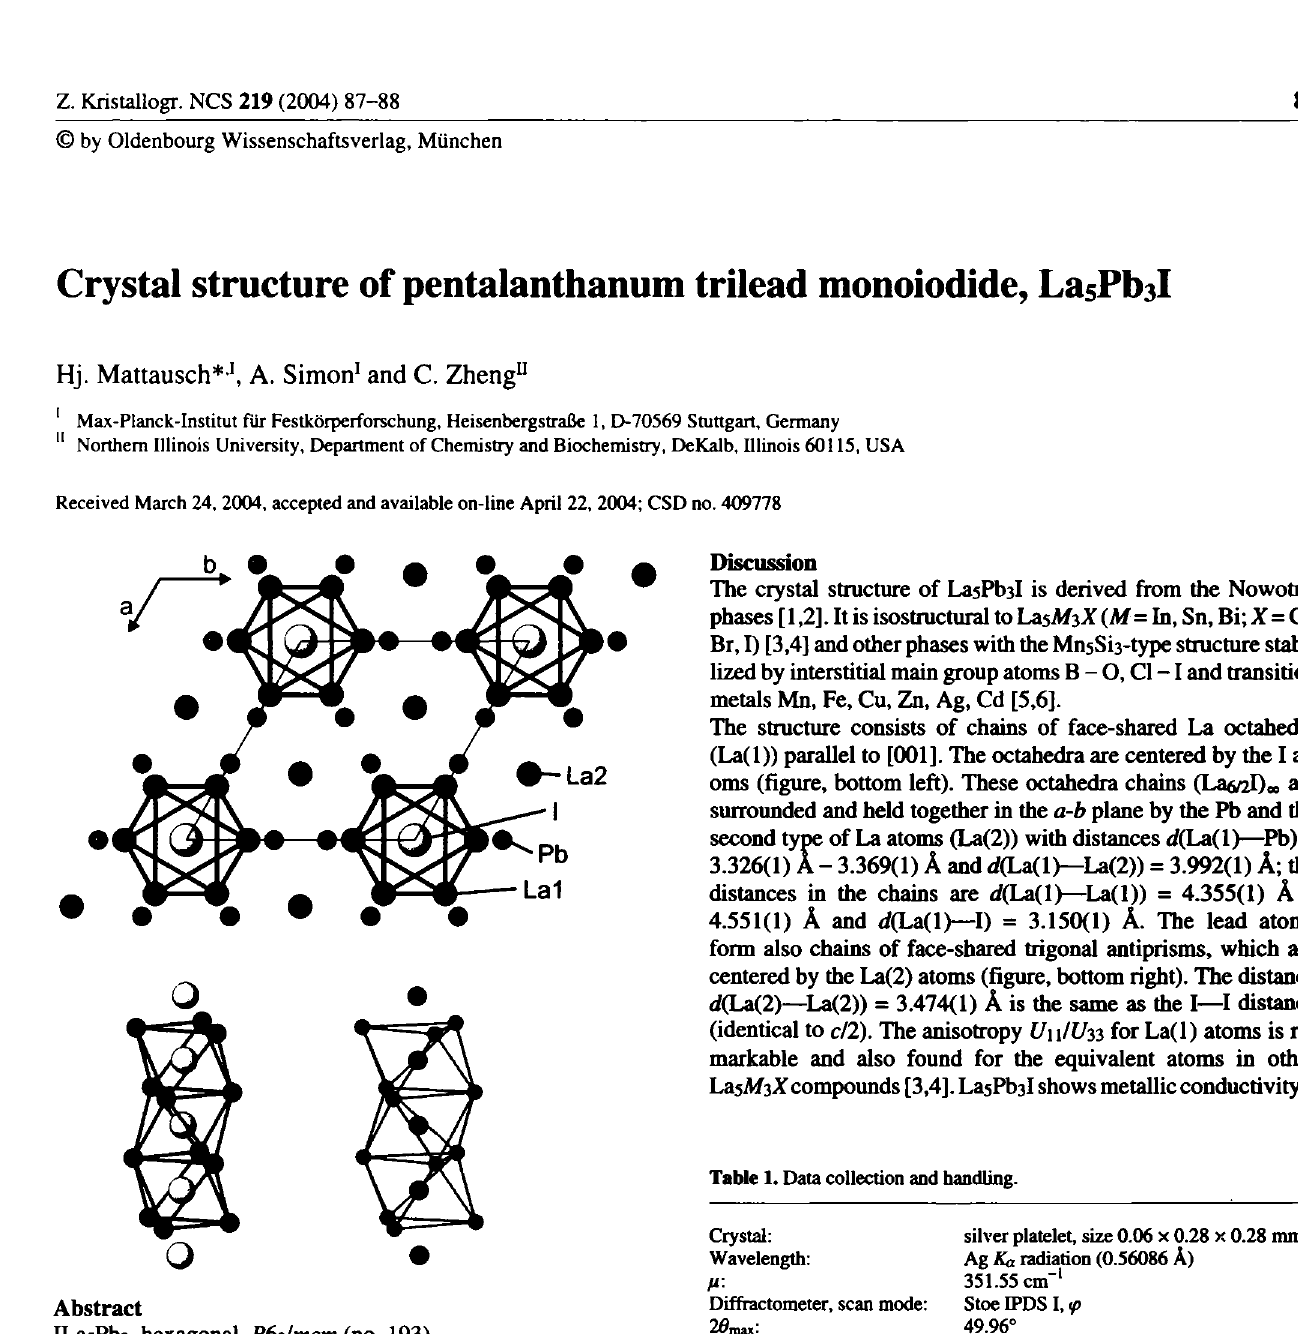
Table 2. Atomic coordinates and displacement parameters (in Â 2